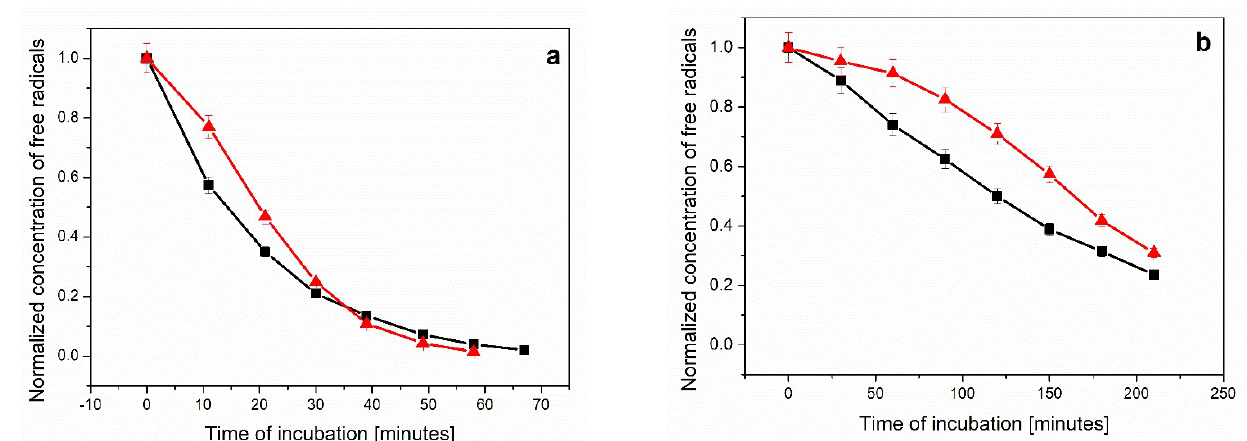
Figure 7. Changes of TEMPO ( a ) and TEMPOL ( b ) concentration in solutions incubated in nitrogen ( ▲ ) and oxygen ( ■ ) atmosphere.